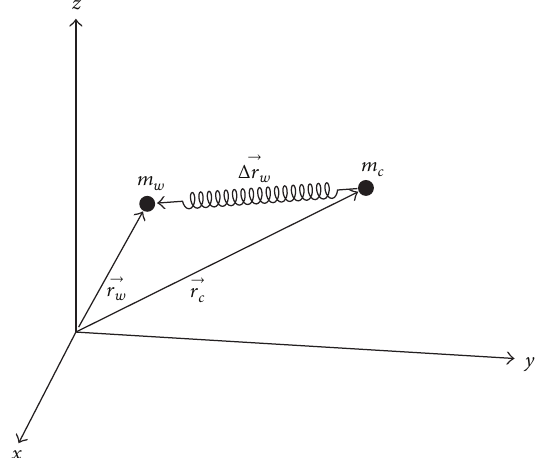
Figure 6: Representation of the vectors associated with the central cell, a neighbor, and the direction of the force exercised by the spring in the neighbor cell direction; cell vectors, the west neighbor, and the spring vector that join them,